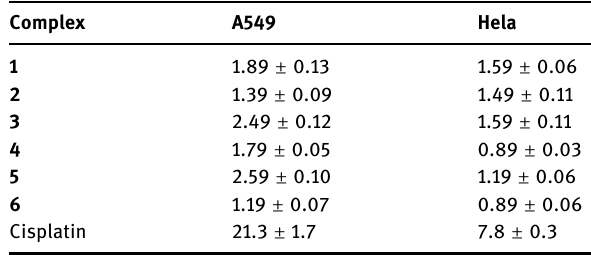
Table 4: IC 50 ( μ M ) of complexes recorded over a period of 24 h a